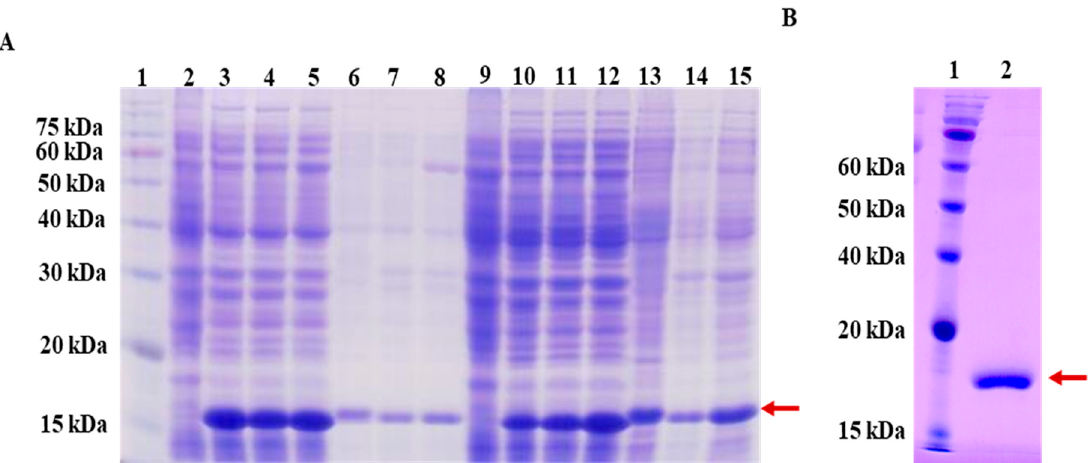
Figure 2. SDS-PAGE analysis of the endolysin LysSE24. ( A ) Lane 1, protein markers; Lane 2, non-induced E. coli BL21 culture (negative control); Lane 3, native protein extract (NPE) from E. coli BL21 induced for 16 h at 16 ◦ C; Lane 4, NPE from E. coli BL21 induced for 4 h at 30 ◦ C; Lane 5, NPE from E. coli BL21 induced for 4 h at 37 ◦ C; Lane 6, denatured protein extract (DPE) from E. coli BL21 induced for 16 h at 16 ◦ C; Lane 7, DPE from E. coli BL21 induced for 4 h at 30 ◦ C; Lane 8, DPE from E. coli BL21 induced for 4 h at 37 ◦ C; Lane 9, non-induced E. coli C41 culture (negative control); Lane 10, NPE from E. coli C41 induced for 16 h at 16 ◦ C; Lane 11, NPE from E. coli C41 induced for 4 h at 30 ◦ C; Lane 12, NPE from E. coli C41 induced for 4 h at 37 ◦ C; Lane 13, DPE from E. coli C41 induced for 16 h at 16 ◦ C; Lane 14, DPE from E. coli C41 induced for 4 h at 30 ◦ C; Lane 15, DPE from E. coli C41 induced for 4 h at 37 ◦ C; the arrow denotes the target protein; ( B ) Lane 1, protein markers; Lane 2, purified endolysin LysSE24 from E. coli BL21 after induction for 16 h at 16 ◦ C; the arrow denotes the target protein.